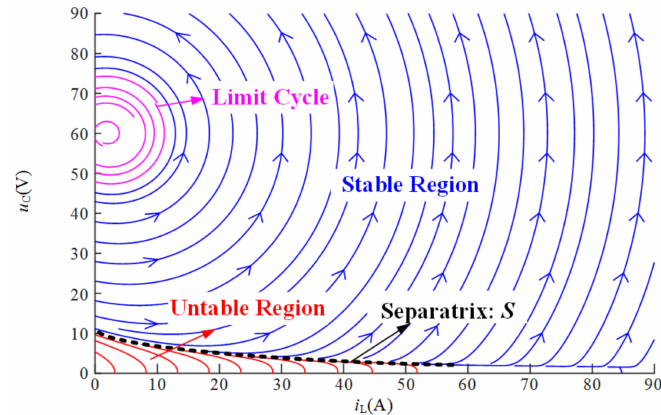
Figure 4. Phase portrait of